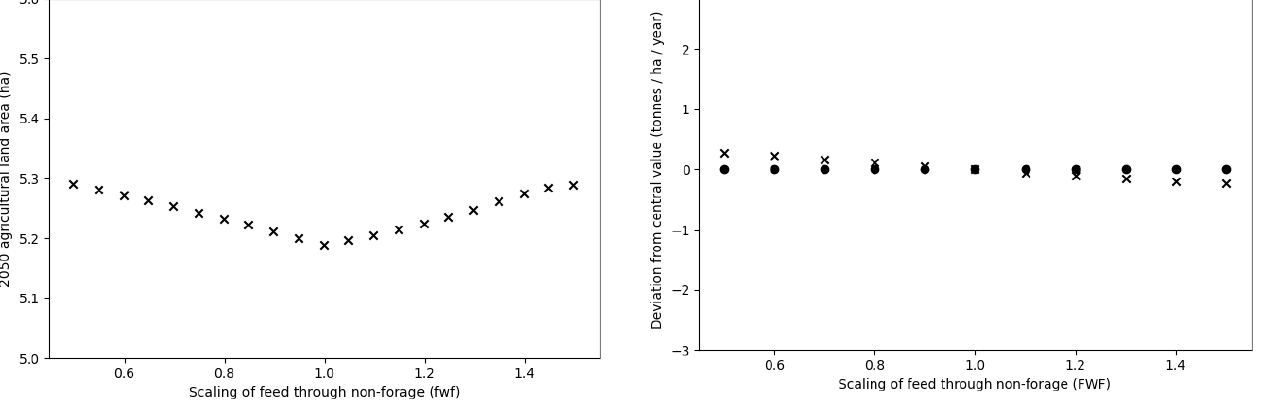
Figure F1. Change in global agricultural land use when varying the proportion of livestock feed from non-forage (FWF).